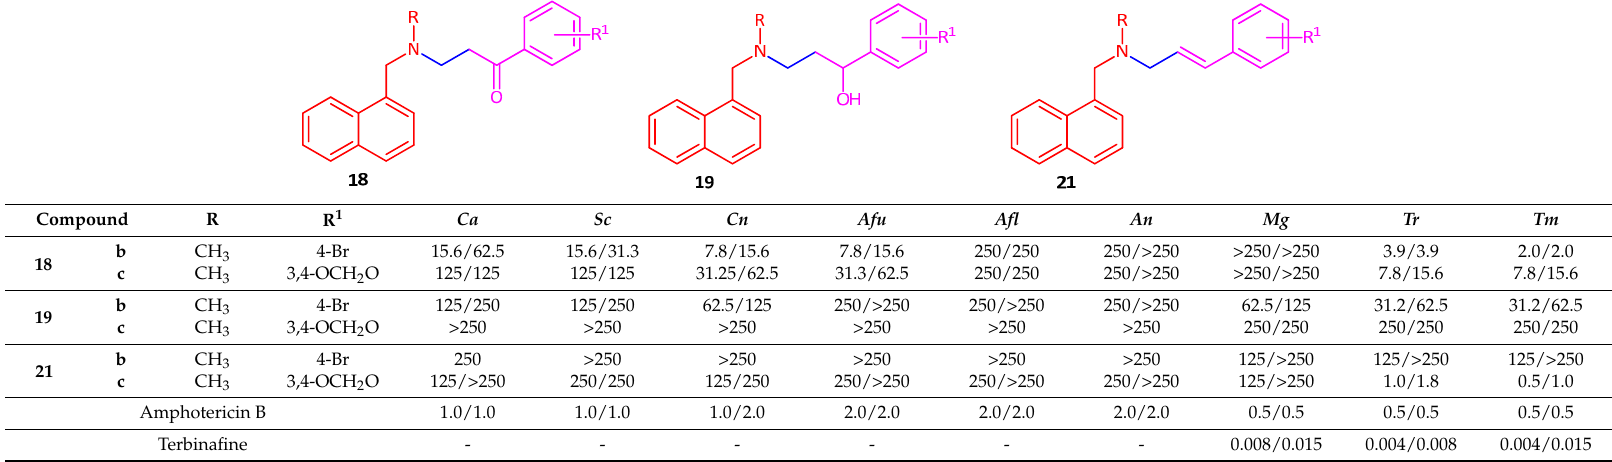
Table 1. MIC values ( µ g/mL) of allylamine derivatives 18 , 19 and 21 acting against human opportunistic pathogenic fungi. MIC/MFC values are recorded in µ g/mL.